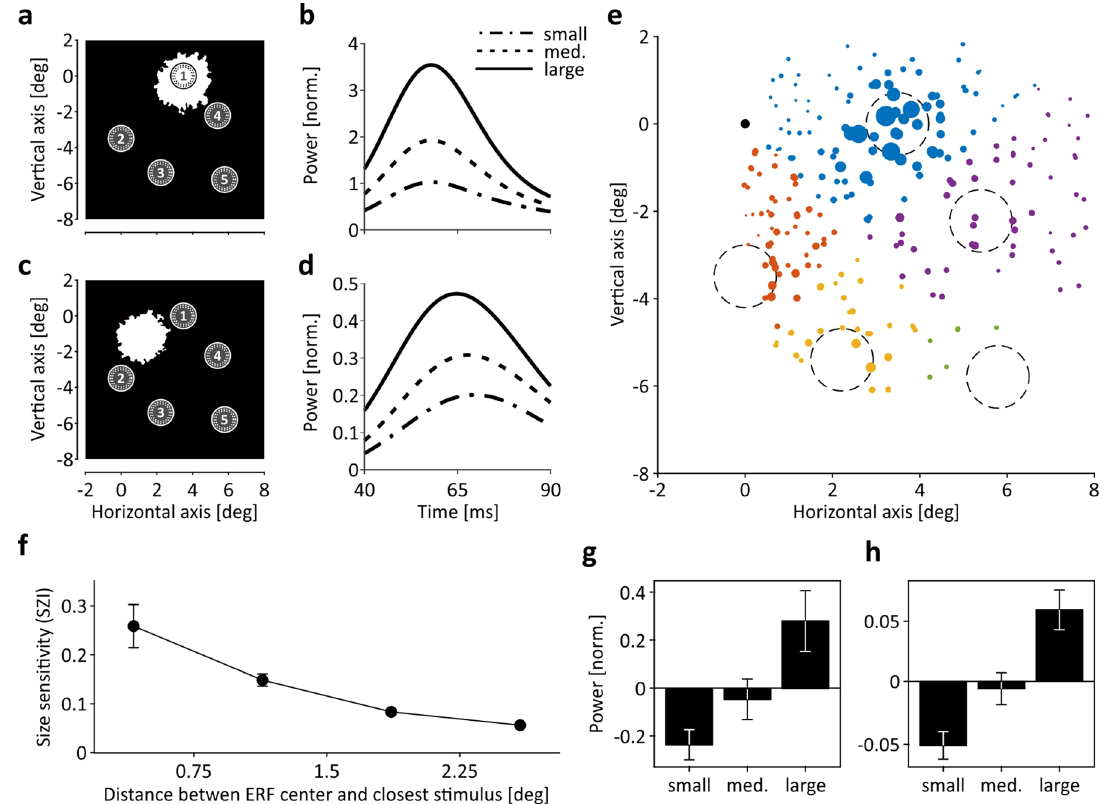
Fig. 4 EFP modulation as function of stimulus size. a Example ERF fully overlapping with stimulus location 1. Closed circles indicate area covered by largest stimuli (1.4-degree in diameter). Dashed circles indicate area covered by medium (1.2-degree) and small (1-degree) stimuli. b Time course of mean power in ROC-selected frequency range in response to large, medium, and small stimuli. c Example ERF not overlapping with any of the stimulus locations 1 – 5. d Time course of the gamma-band response measured at this electrode. e Size sensitivity map in visual fi eld coordinates. Colors indicate assigned location per electrode, given by smallest Euclidian distance. Dot size is scaled by size sensitivity SZI . Circles indicate areas covered by large stimuli. f Averaged size sensitivity as function of center-to-center distance between ERF and closest stimulus, as obtained from data shown in ( c ). g – h Averaged response strength to small, medium, and large stimuli at electrodes with ERF centers <0.75-degree distance ( g ) and between 2.25 and 3-degree distance ( h ) from stimulus center. Individual data points for all stimulus/ERF distances are shown in Supplementary Fig. 1. Error bars indicate SEM